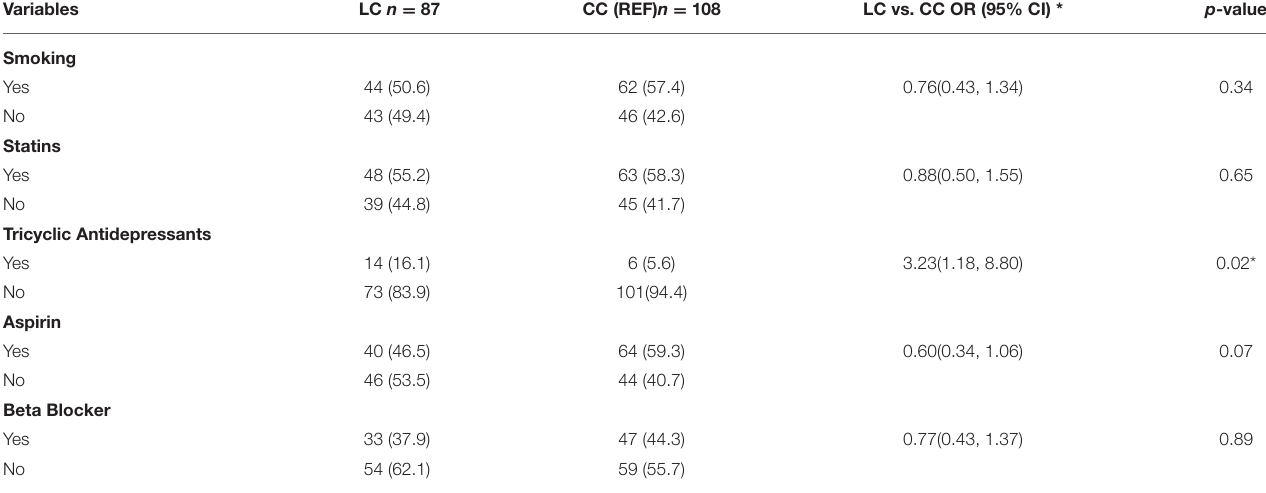
TABLE 2 | Association of smoking and medication with LC compared with CC. Variables